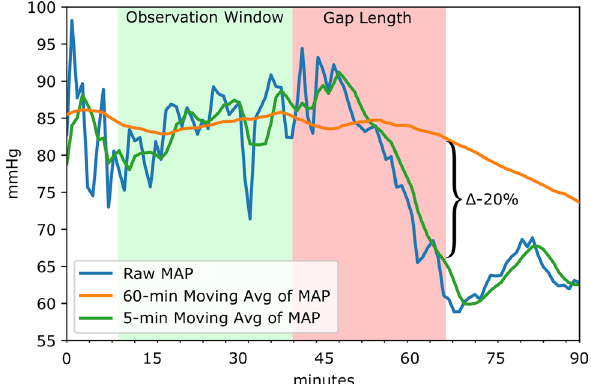
Figure 5. An example of an identified event in a patient recording. The annotated 20% drop is representative of the difference between a 60 min moving average (orange) and a 5 min moving average (green) of MAP. The relationship between the intervals of time that represent the observation window (highlighted green) and gap length (highlighted red) are also depicted relative to the identified drop in